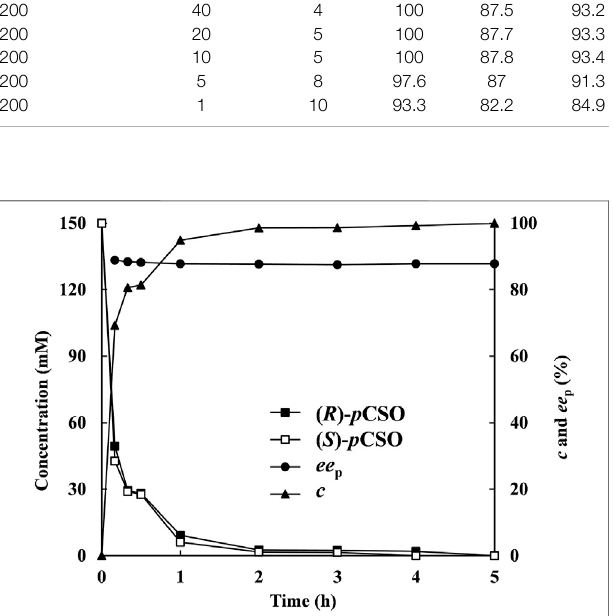
FIGURE 6 | The hydrolysisof300 mM rac-p CSO in the 4% (v/v) Tween- 20/phosphatebuffersystem(100 mM,pH7.0)by E.coli / rpeh F361V and E.coli / pveh 1 z4x4-59 undertheoptimizedconditions — thetimecoursesof( R )-and( S )- p CSO concentrations, c of rac-p CSO and ee p of ( R )-PED.